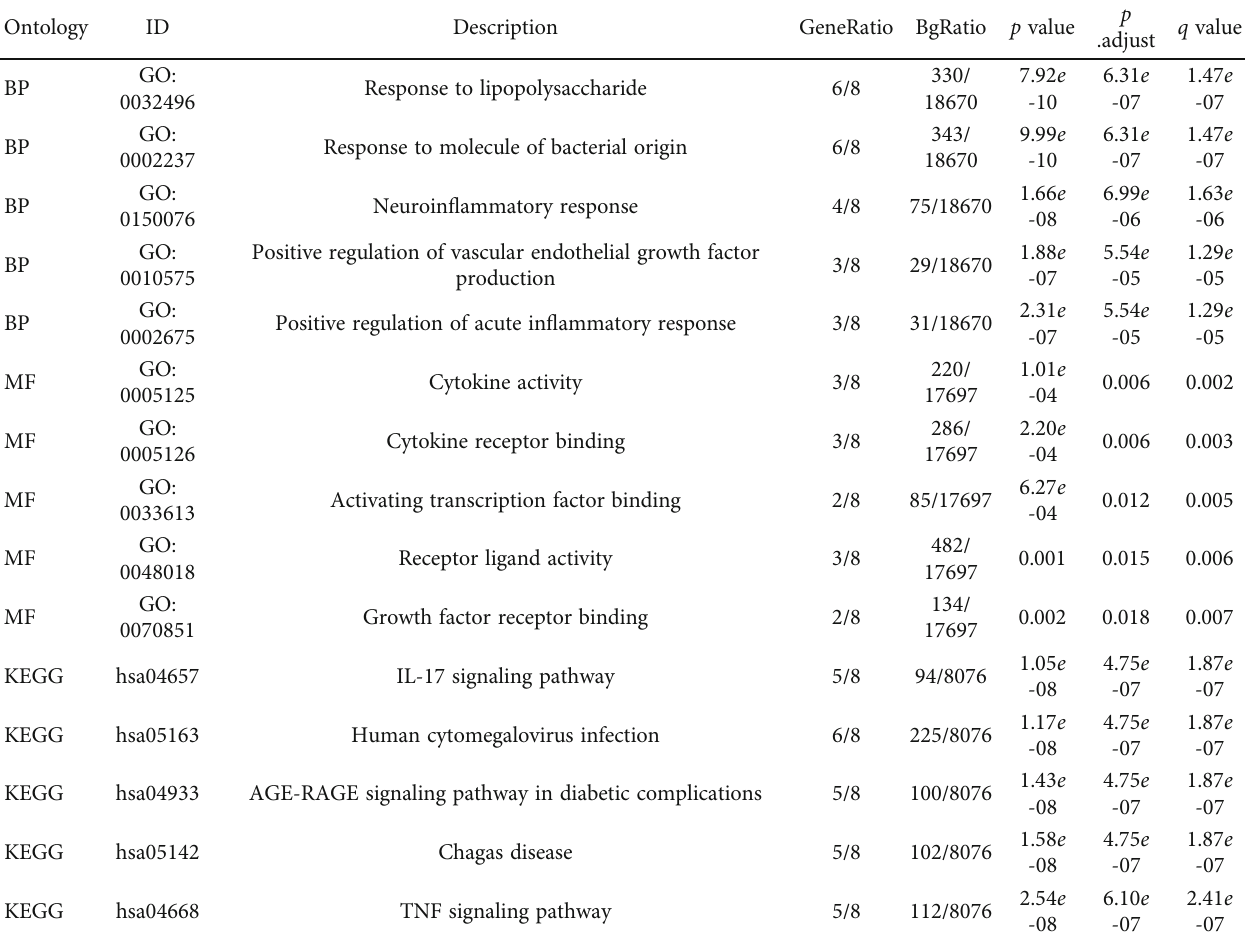
Table 2: Top 5 results of enrichment analysis of BP, CC, MF, and the pathways of SQP.